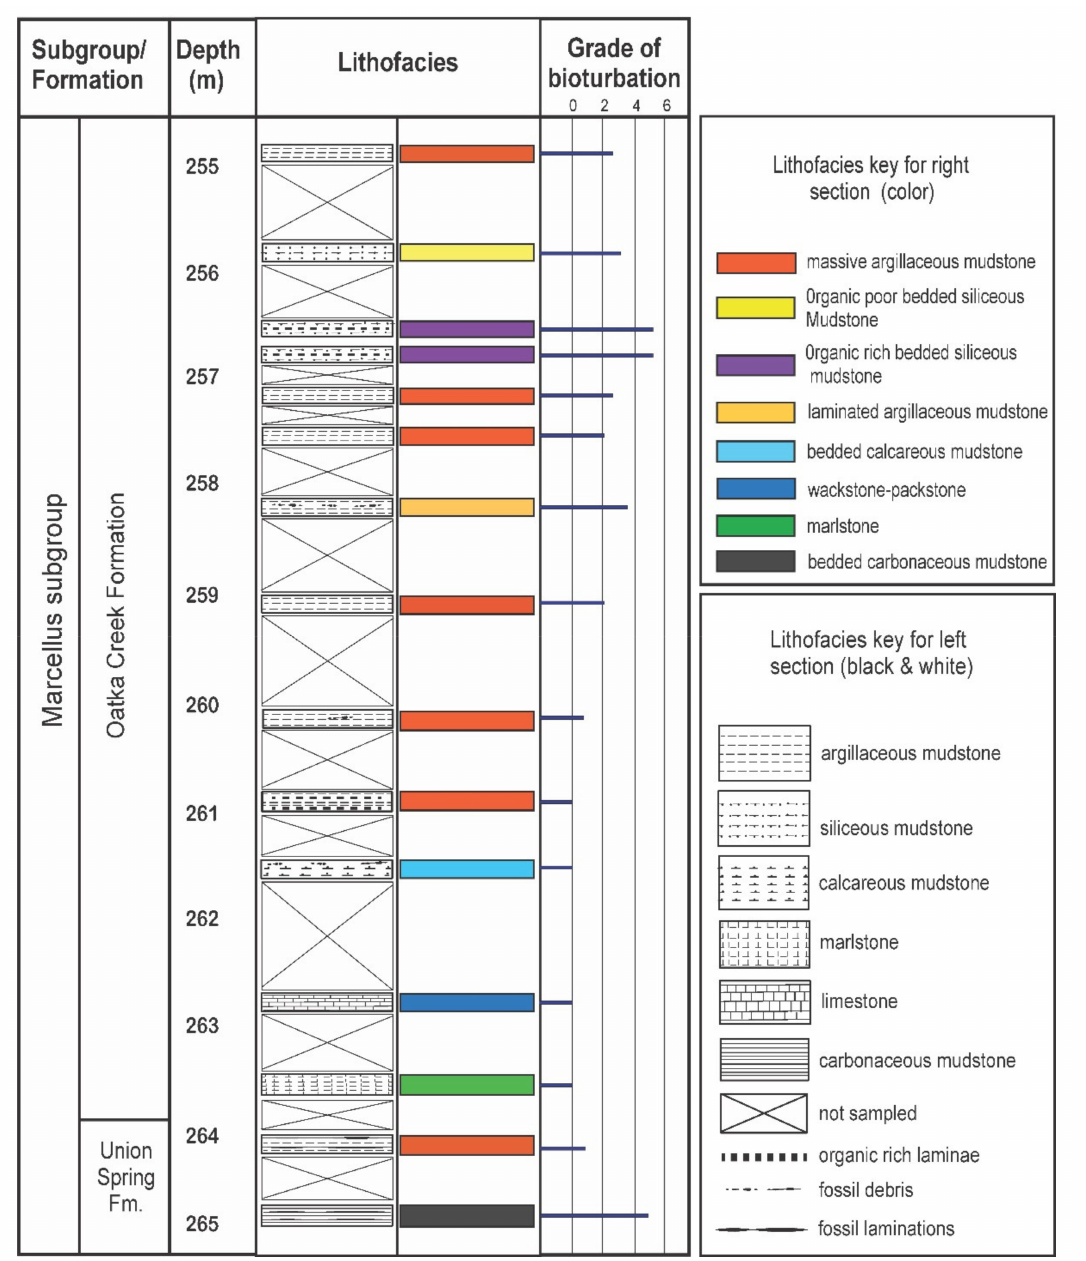
Figure 3. Log showing the lithofacies distribution and the grade of bioturbation